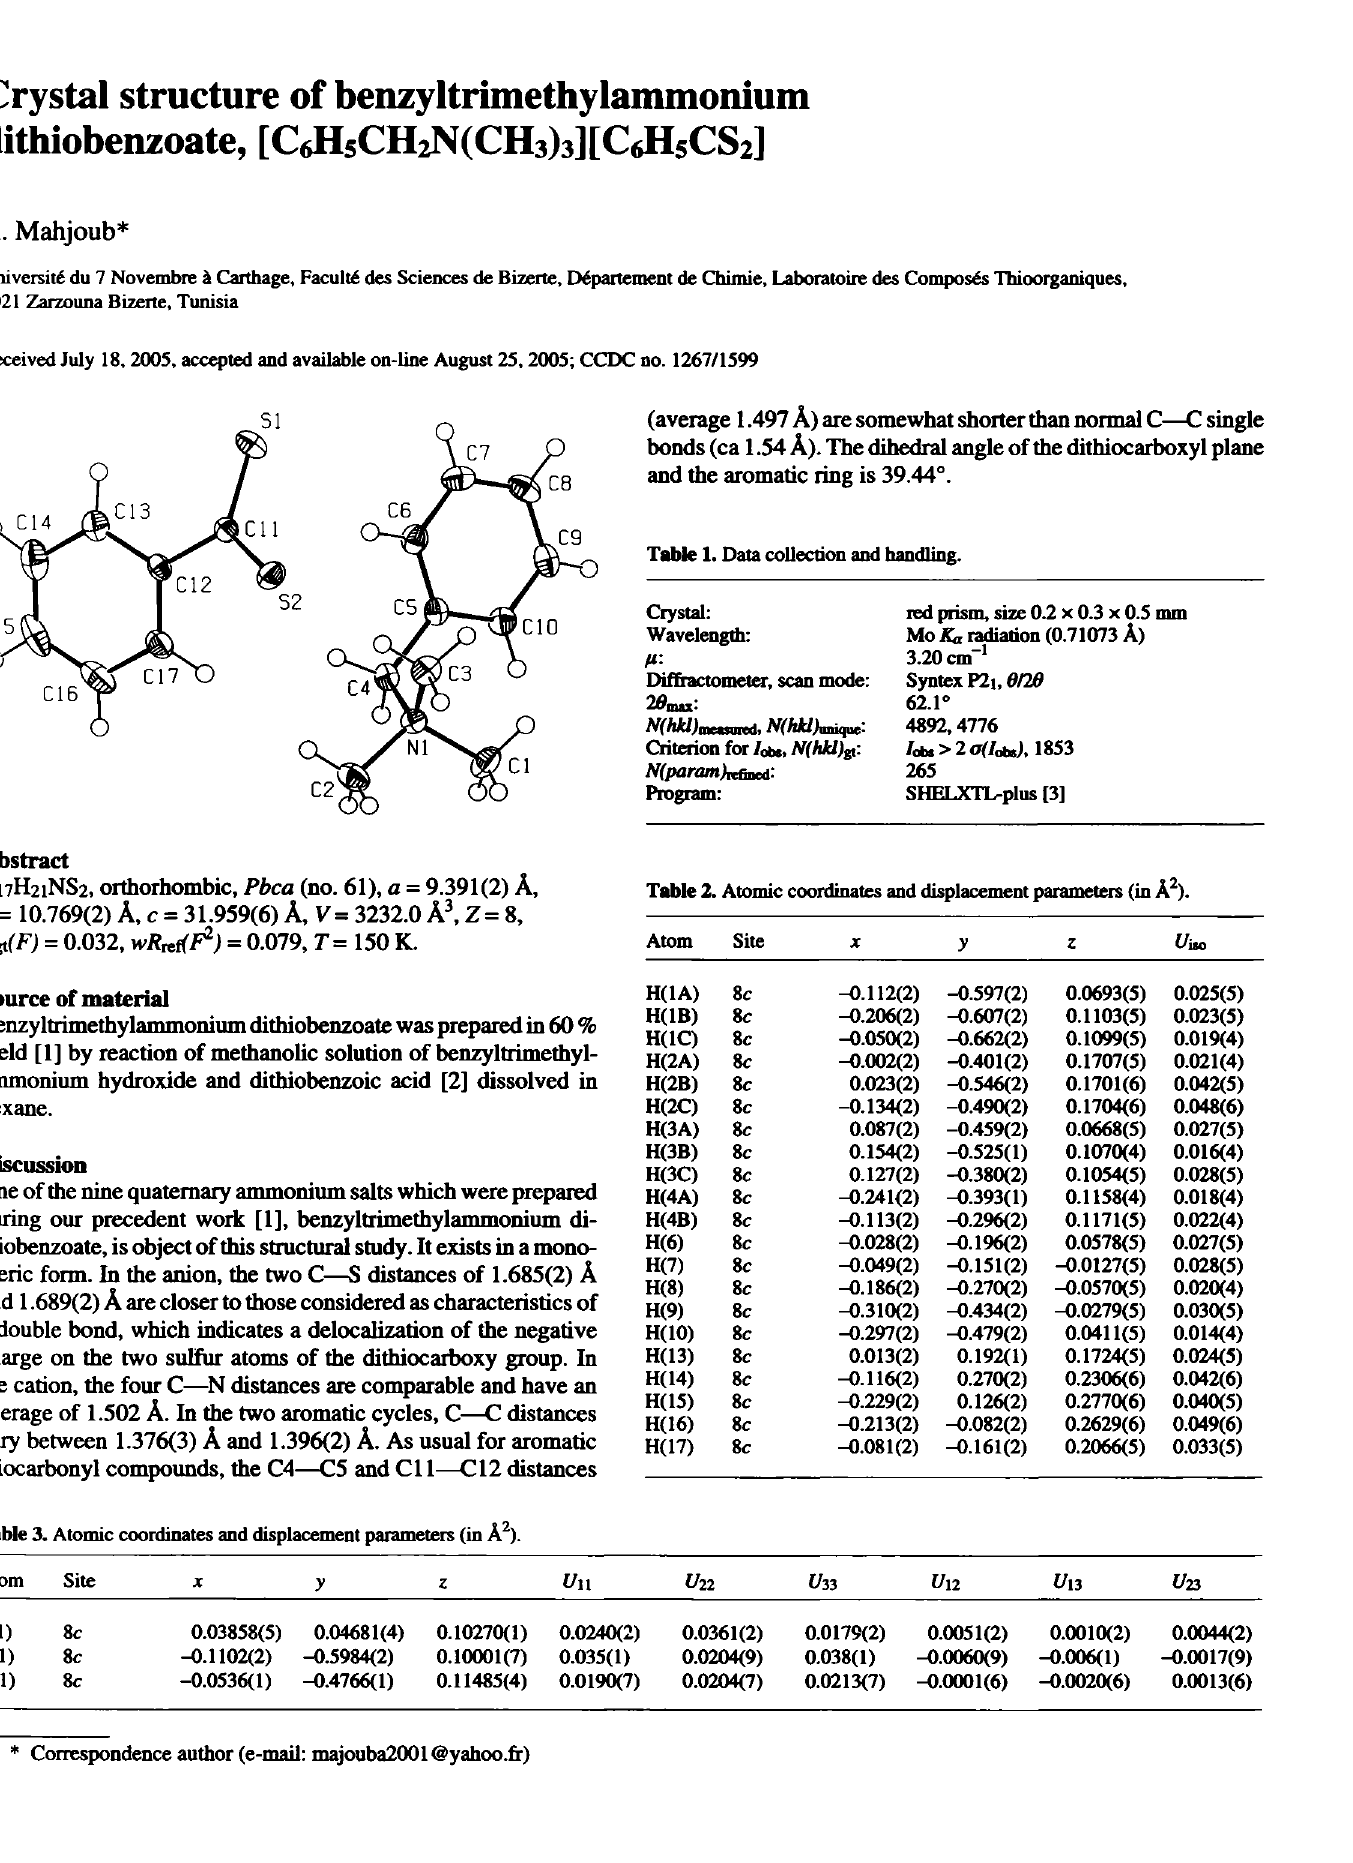
Table 1. Data collection and handling. Crystal: Wavelength: /*• Diffractometer, scan mode: AWWaramd, N(hklh^: Criterion for /at», N(hM) p :